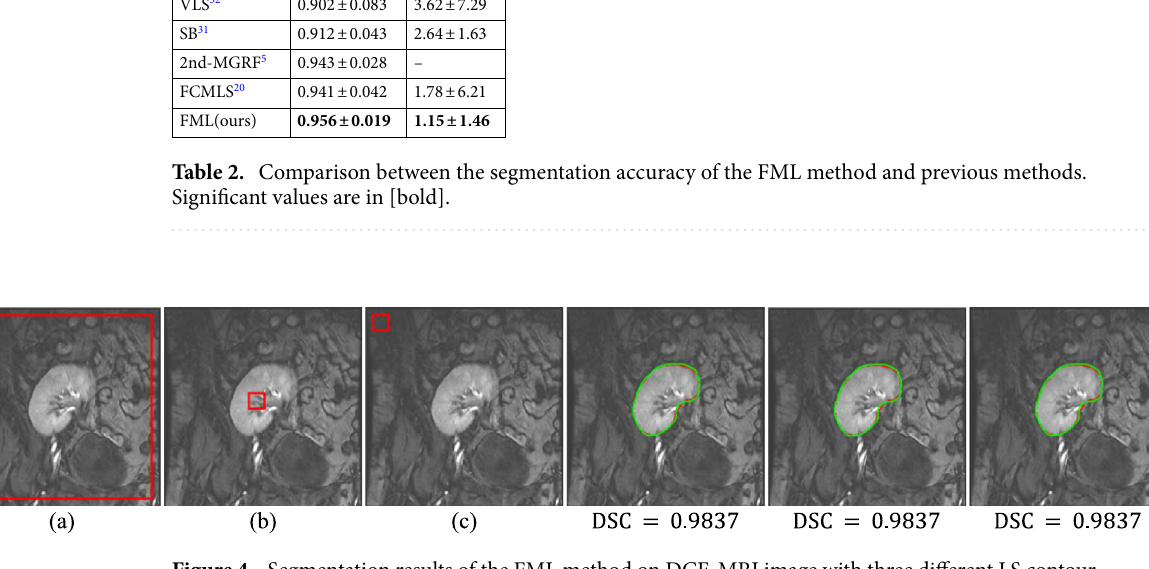
Figure 4. Segmentation results of the FML method on DCE-MRI image with three different LS contour initializations. ( a – c ) show DCE-MRI image with initial contours outlined in red. Last three columns show segmentation results of ( a – c ) in red while ground-truth segmentations are outlined in green, with DSC reported beneath each